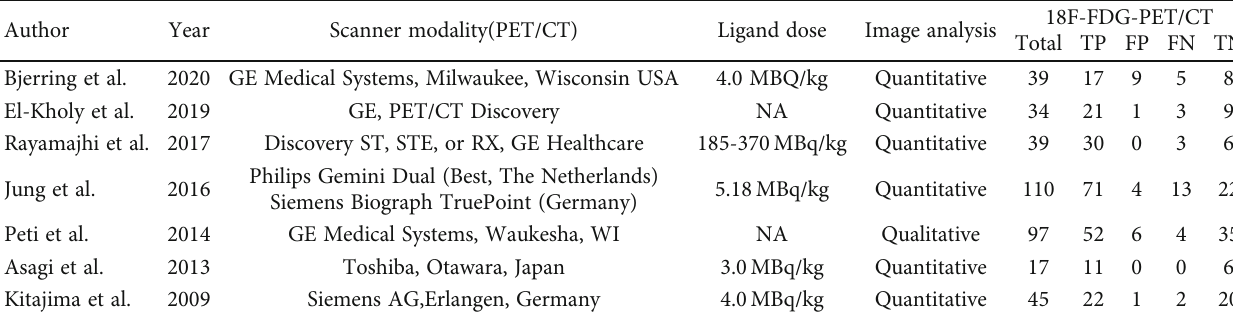
Table 2: Technical aspects of included studies.